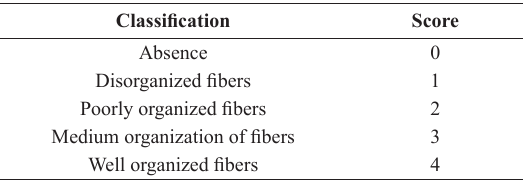
Table 1. Classification of the tissue repair pattern regarding quality, quantity and orientation of collagen fibers.